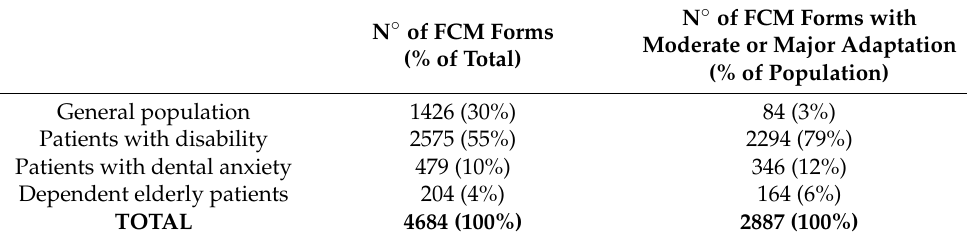
Table 2. Distribution of FCM forms relating to different patient populations. N ◦ of FCM Forms with N ◦ of FCM Forms Moderate or Major Adaptation (% of Total) (% of Population) General population 1426 (30%) 84 (3%) Patients with disability 2575 (55%) 2294 (79%) Patients with dental